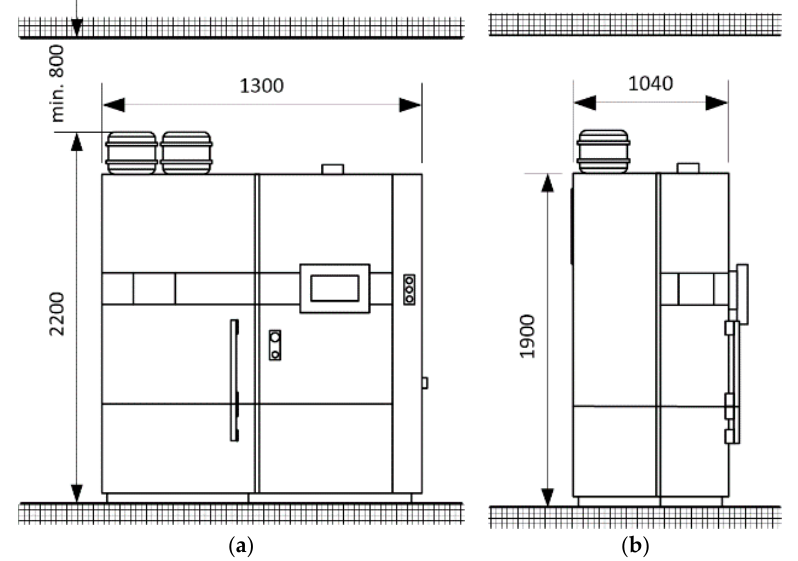
Figure 1. Main dimensions of an exemplary SLS device, dimensions in [mm]: ( a ) Front view of machine; ( b ) Side view of machine [34].